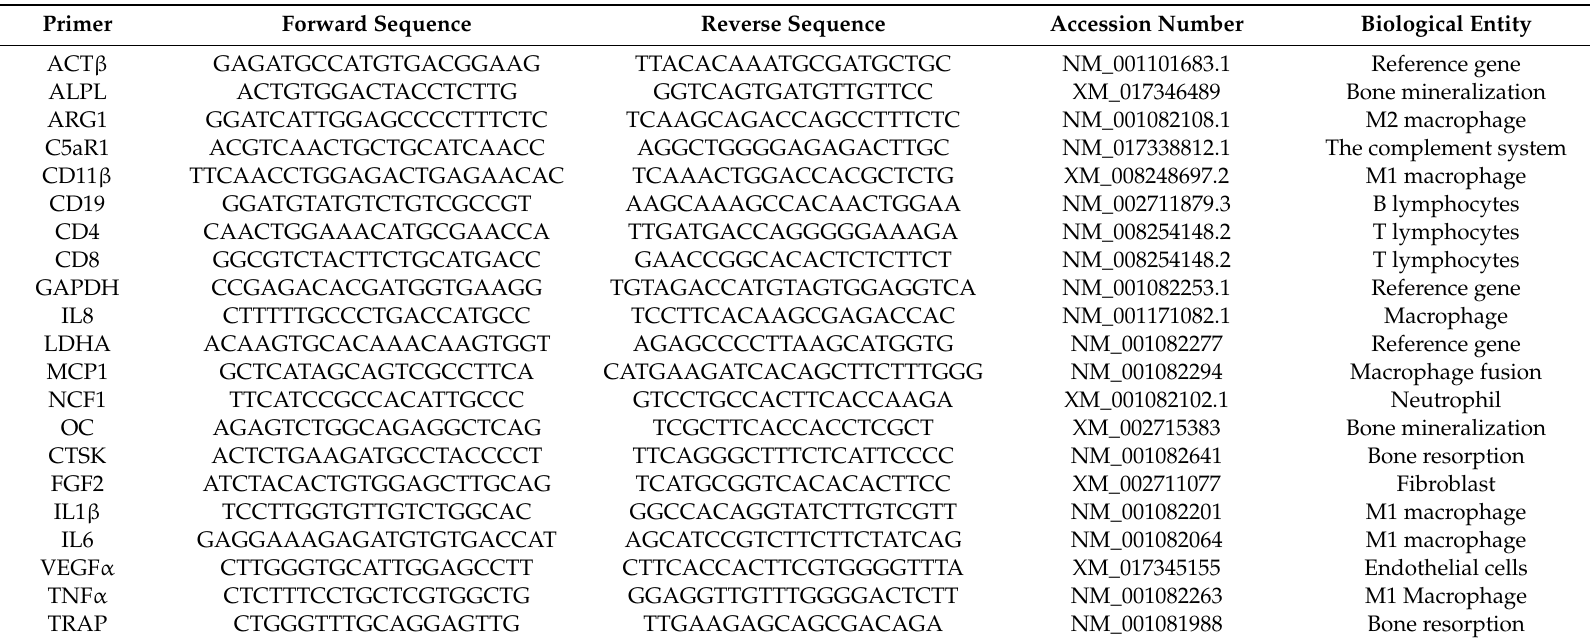
Table 1. Gene sequences and biological